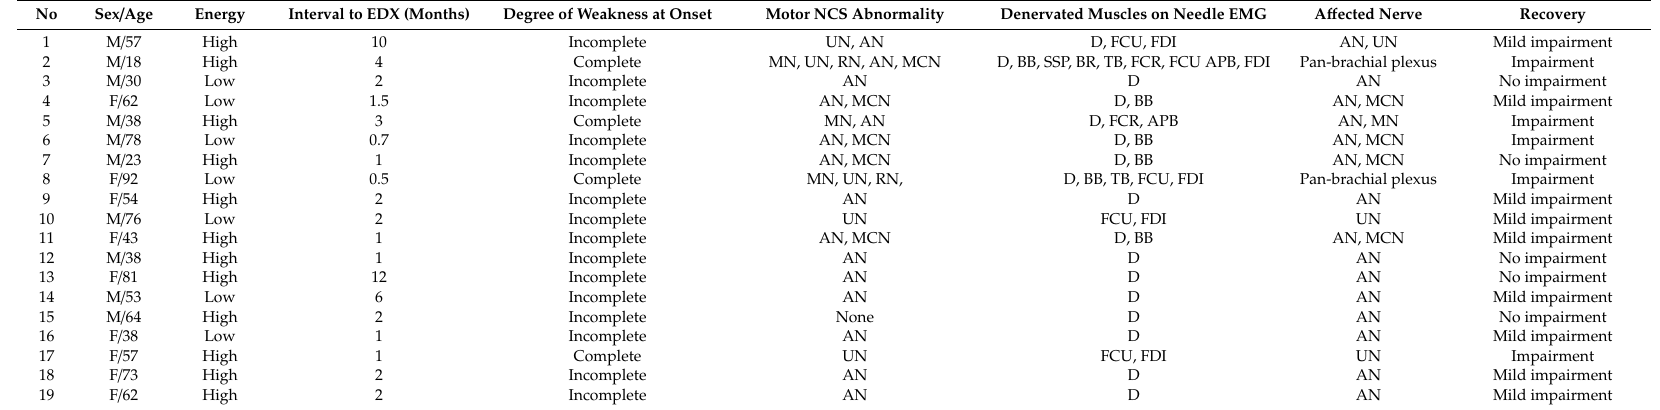
Table 2. Detailed Description of the Peripheral Nerve Injuries in 19 Patients with Proximal Humerus